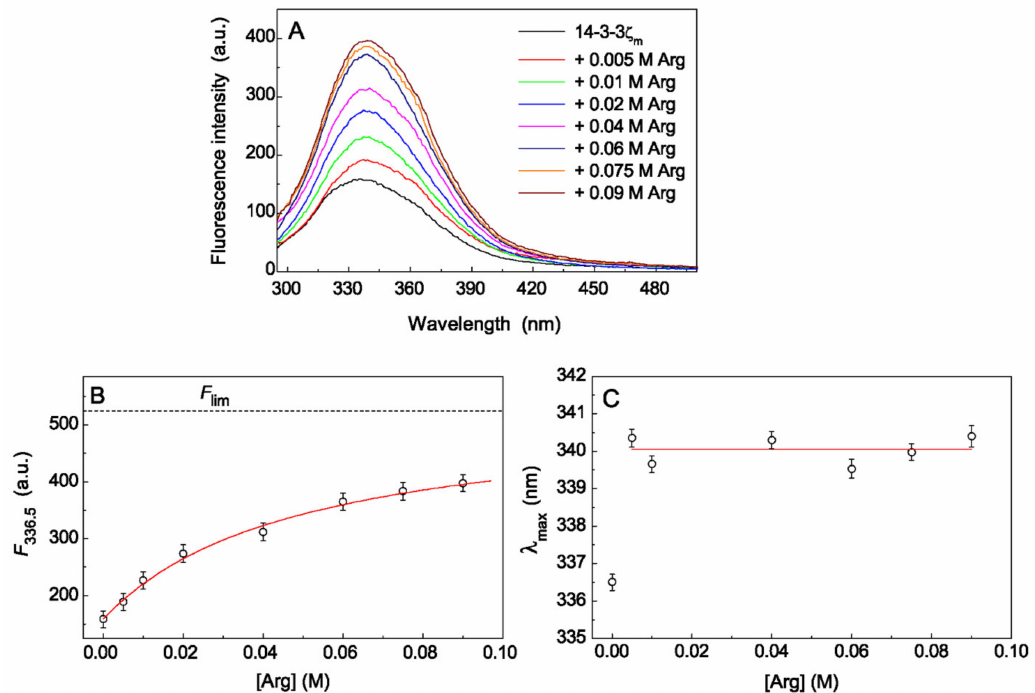
Figure 6. The e ff ect of Arg on tryptophan fluorescence of 14-3-3 ζ m . ( A ) The tryptophan fluorescence spectra of 14-3-3 ζ m (0.48 mg / mL) in 0.03 M Hepes-bu ff er, containing 0.5 mM DTT, and in the presence of increasing concentrations of Arg from 0 to 0.09 M. The spectra were obtained at 25 ◦ C, excitation wavelength of 292 nm and constant ionic strength of 0.15 M. ( B ) The dependence of fluorescence intensity on Arg concentration at λ = 336.5 nm. Points are the experimental data. The solid curve was calculated using Equation (4) at K diss = 0.049 M, F 0 = 159 and F lim = 524. The horizontal dash line corresponds to F lim value. ( C ) The dependence of Trp emission maximum ( λ max ) on Arg